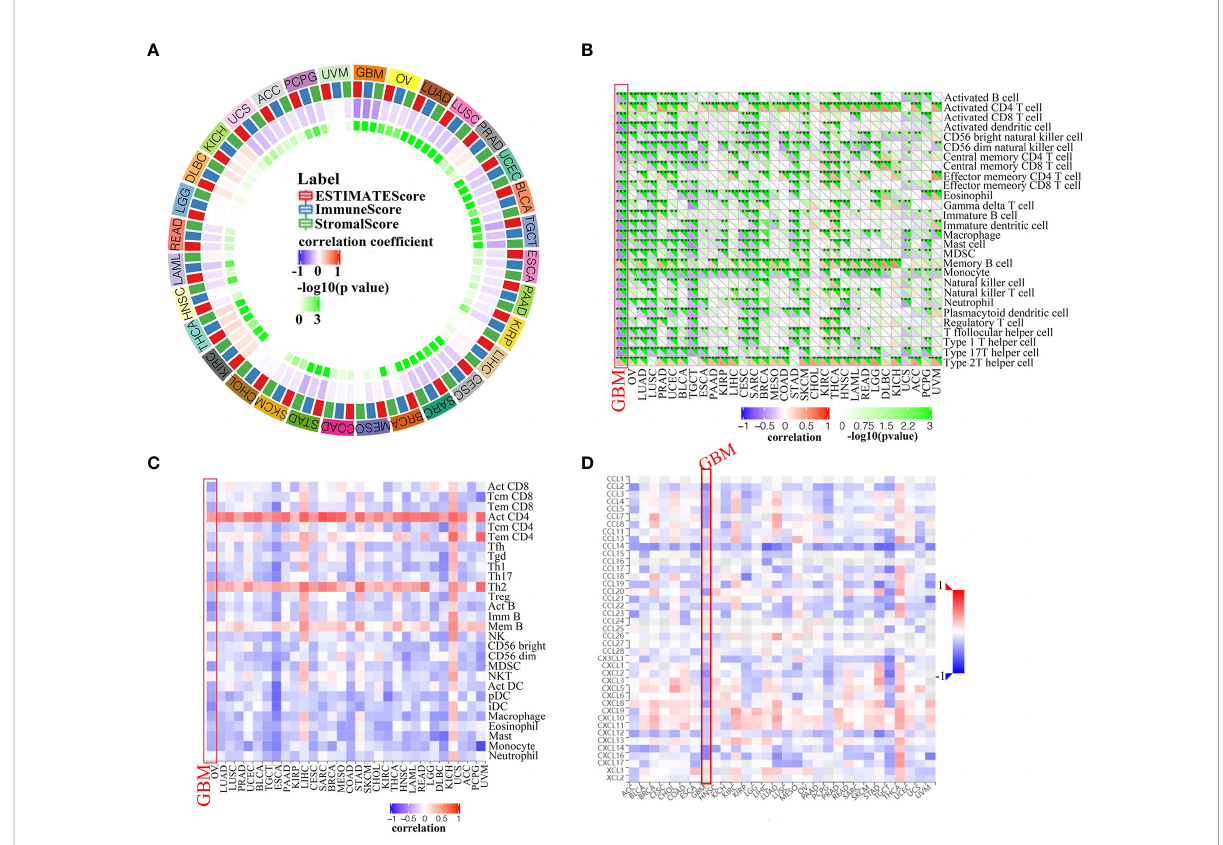
FIGURE 6 Correlation analysis between PLK4 expression and immune in fi ltration levels. (A) Analyzing the correlation between PLK4 expression and ESTIMATE scores in various tumors was performed by Sangerbox. (B) According to the Sangerbox website, PLK4 expression correlates with immune cell in fi ltration in various types of tumors. * P <0.05, ** P <0.01, *** P <0.001, (C) An analysis of the relationship between PLK4 expression levels in tumor tissues and abundance of tumor-in fi ltrating lymphocytes (TILs) was performed using the online tool TISIDB. (D) Analysis of the relationship between PLK4 expression levels in tumor tissues and chemokines was performed using the online tool